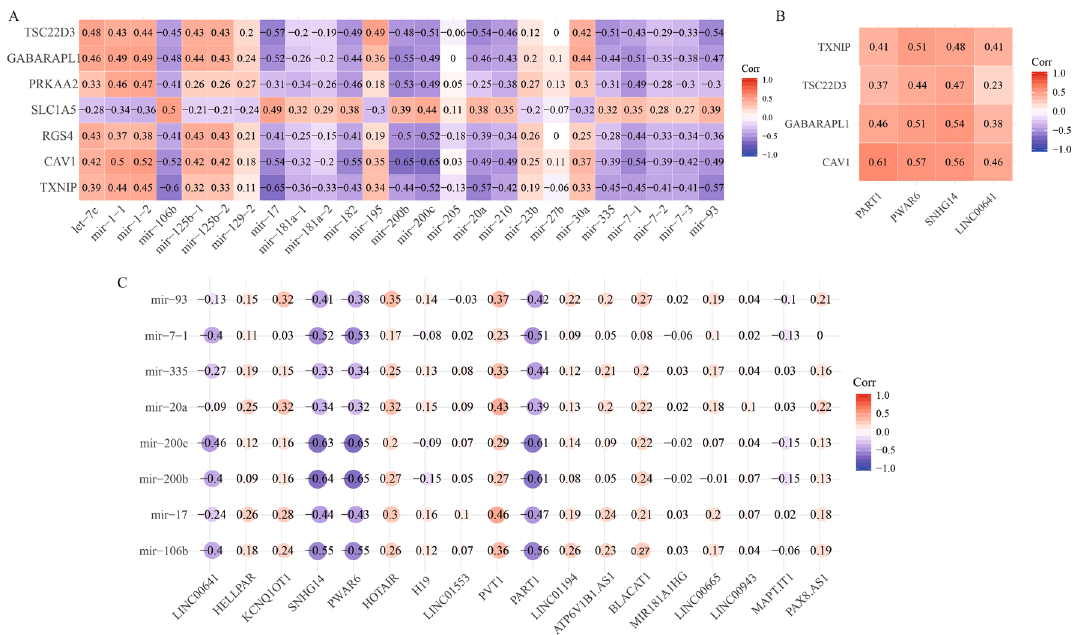
Figure 5. Correlation between the expression of ncRNAs and ferroptosis-related genes in gastric cancer. ( A ) Pearson correlation between the expression level (log2-transformed RPM/FPKM value) of upstream DEmiRNAs and survival-related genes. ( B ) Pearson correlation between the expression level (log2-transformed FPKM value) of upstream DElncRNAs and ferroptosis-related genes. ( C ) Pearson correlation between the expression level (log2-transformed FPKM/RPM value) of upstream DElncRNAs and DEmiRNAs associated with ferroptosis. Corr: Pearson correlation coefficient.